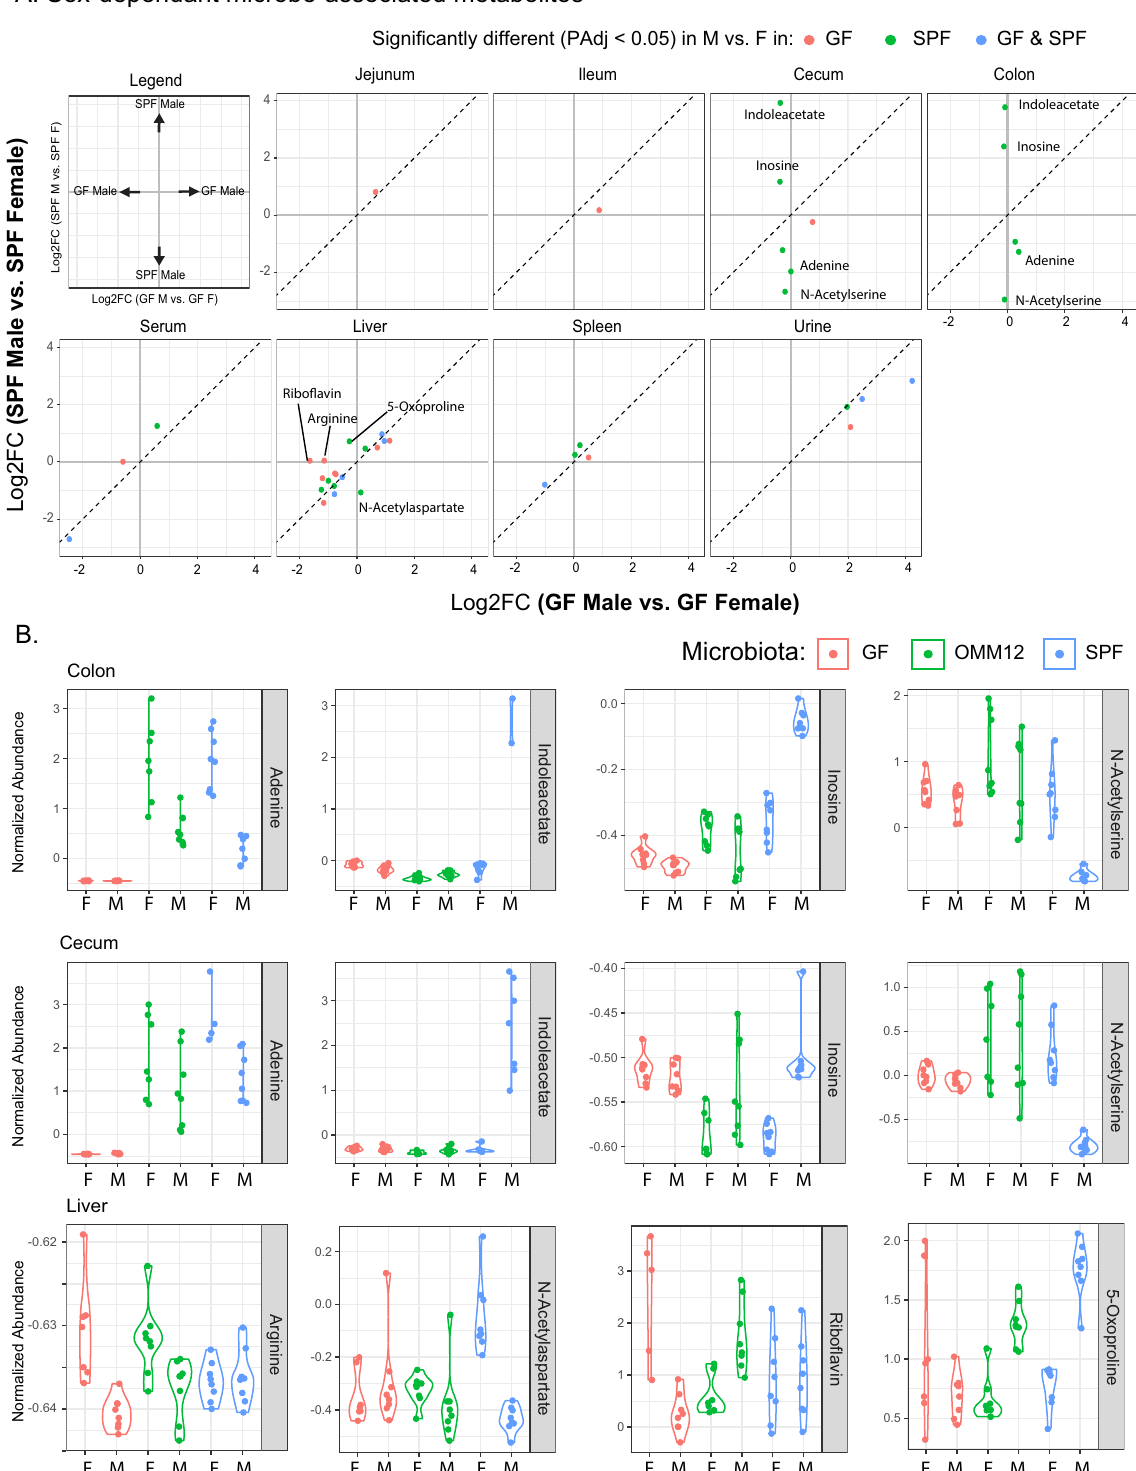
Fig. 5 | Sex-speci fi c changes in microbiota-associated metabolism. A Biplot showing the Log2FCinmetabolitesthat were signi fi cantlydifferent (PAdj<0.05)in malevs.femaleSPFmiceormalevs.femaleGFmice.Metabolitesweresigni fi cantly differentbasedonageineitherGF(red)orSPF(green)orinbothGFandSPF(blue). B Violin plots of highlighted metabolites from A that are differentially affected by